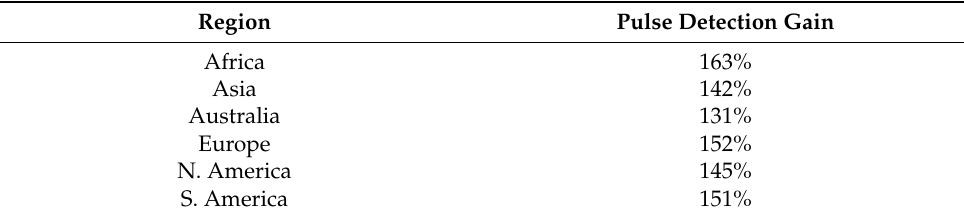
Table 4. Detection gains of P2021 compared to P2015 in different regions (calculated using lightning pulses detected between 3 December 2021 and 14 April 2022).